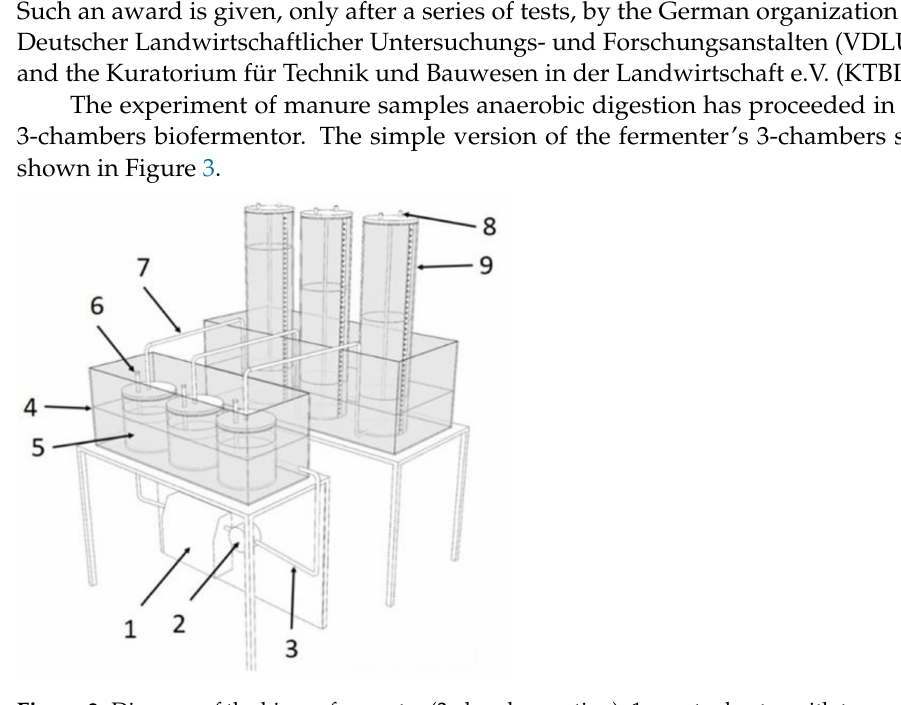
Figure 3. Diagram of the biogas fermenter (3-chamber section): 1—water heater with temperature reg- ulator, 2—water pump, 3—insulated conductors of calefaction liquid, 4—water coat,